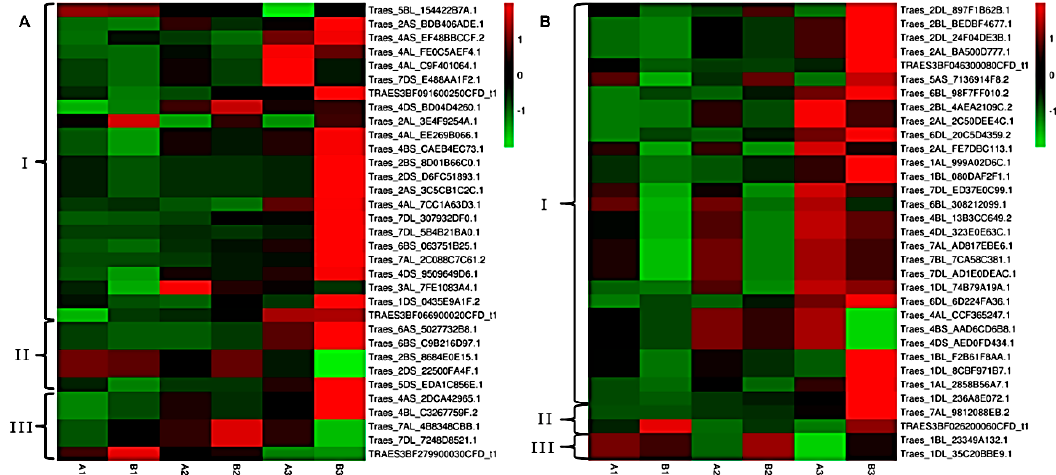
Figure 7. Hierarchical clustering analysis of differentially abundant proteins (DAPs) with different functions during grain development. ( A ) DAPs involved in energy metabolism, including starch and sucrose metabolism (A-I), glycolysis/gluconeogenesis (A-II) and pyruvate metabolism (A-III). ( B ) DAPs involved in carbohydrate metabolism, including oxidative phosphorylation (B-I), nitrogen metabolism (B-II) and photosynthesis (B-III).